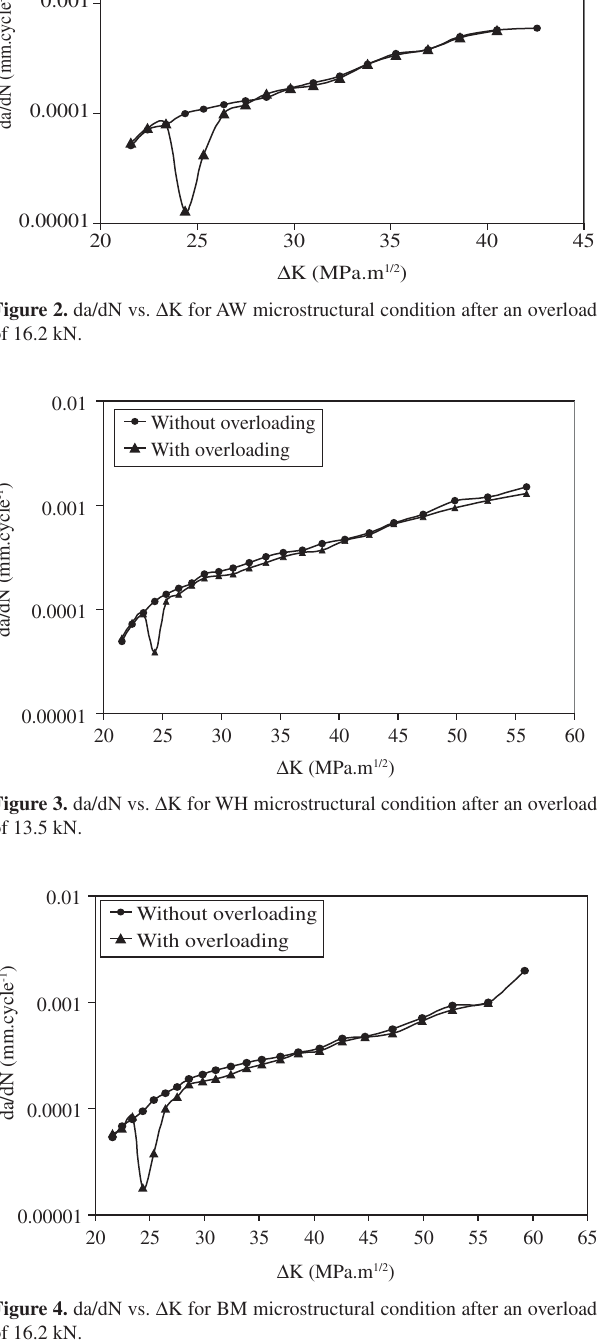
Figure 4. da/dN vs. ∆ K for BM microstructural condition after an overload of 16.2 kN.